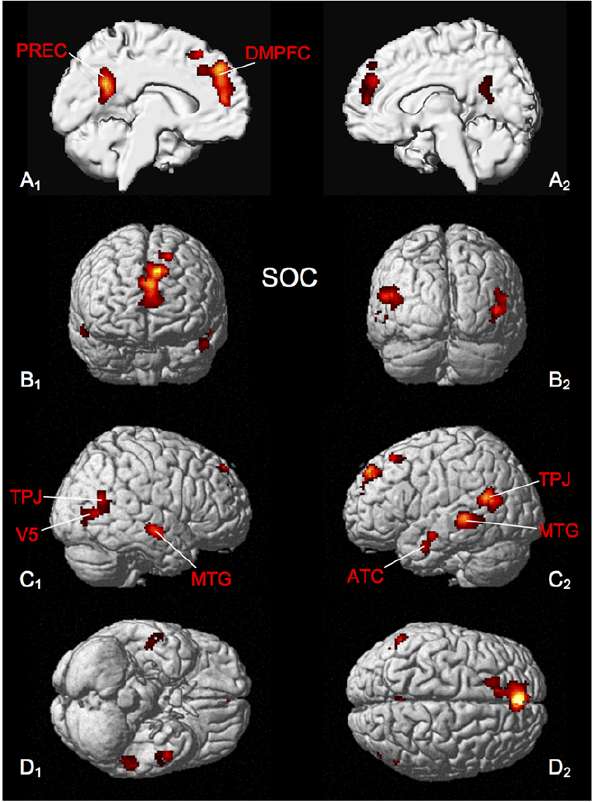
Figure 1. Significant results of the ALE meta-analysis for social cognition tasks (SOC). All results are displayed on the left and right lateral surface view, the anterior/posterior and dorsal/ventral view of the Montreal Neurological Institute (MNI) single subject template. ATC: anterior temporal cortex, DMPFC: dorso-medial prefrontal cortex, MTG: middle temporal gyrus, PCC: posterior cingulate cortex, PREC: precuneus, TPJ: temporo-parietal junction.